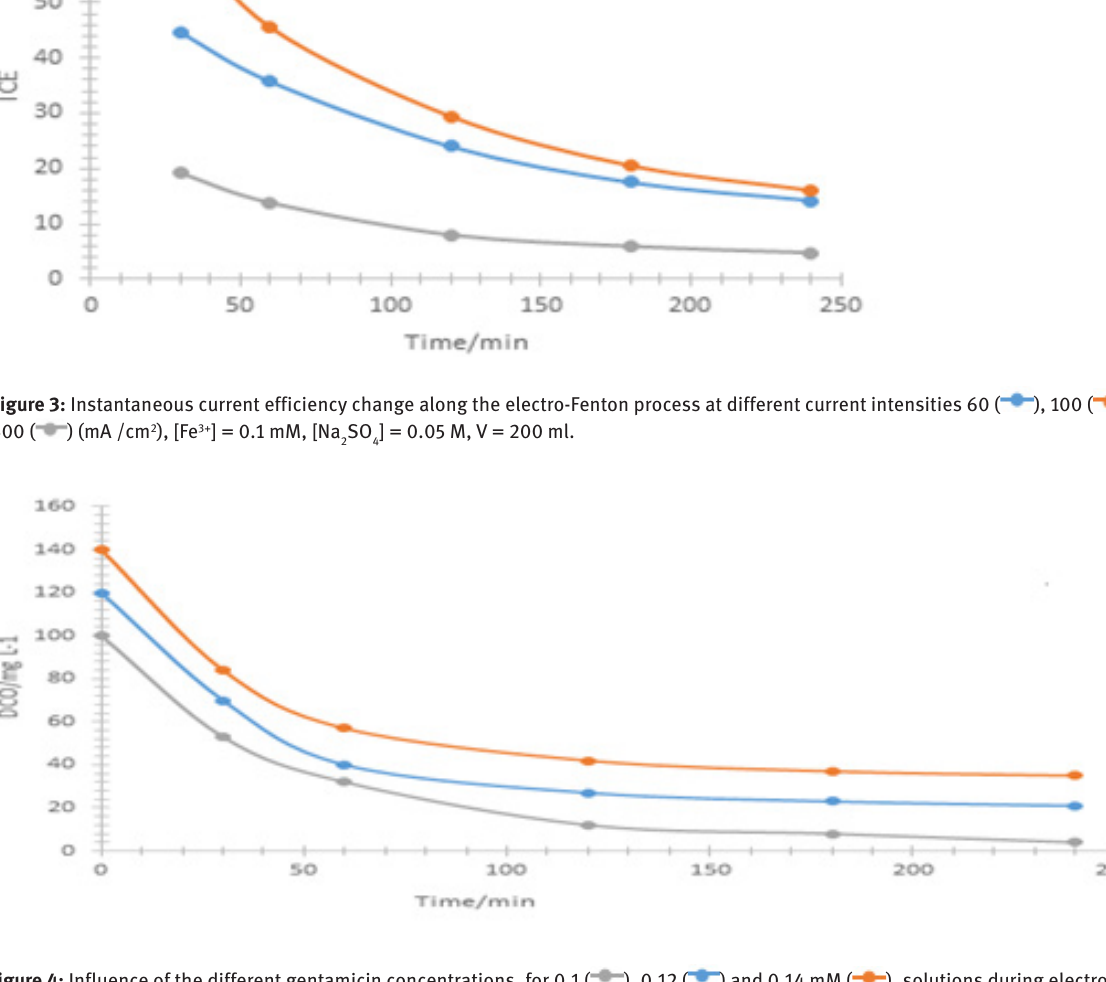
SO ] = 0.05 M, 100 (mA /cm 2 ) and V = 200 2 4